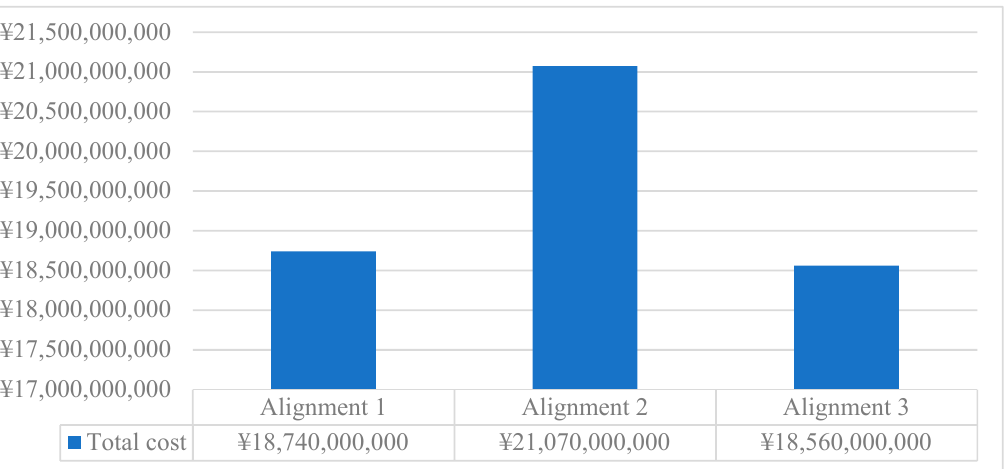
Figure 15. Cost items for the three alignment alternatives.